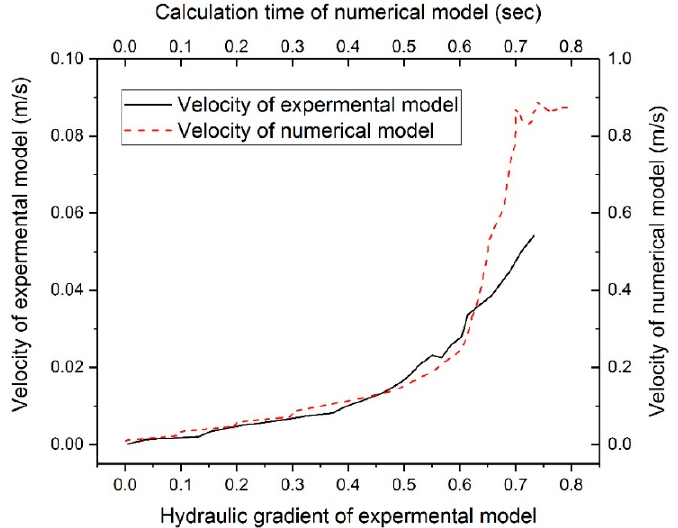
Figure 13. Evolution of velocity with change in hydraulic gradient in experimental model and numerical model.